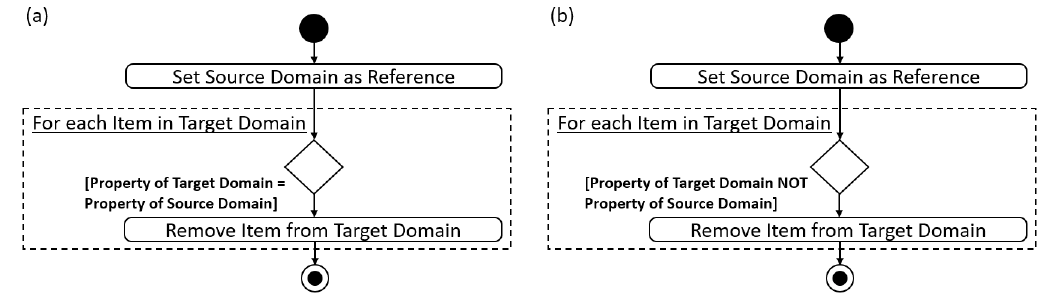
Figure 10. Activity diagram for inequality ( a ) and equality ( b ) constraint handling.